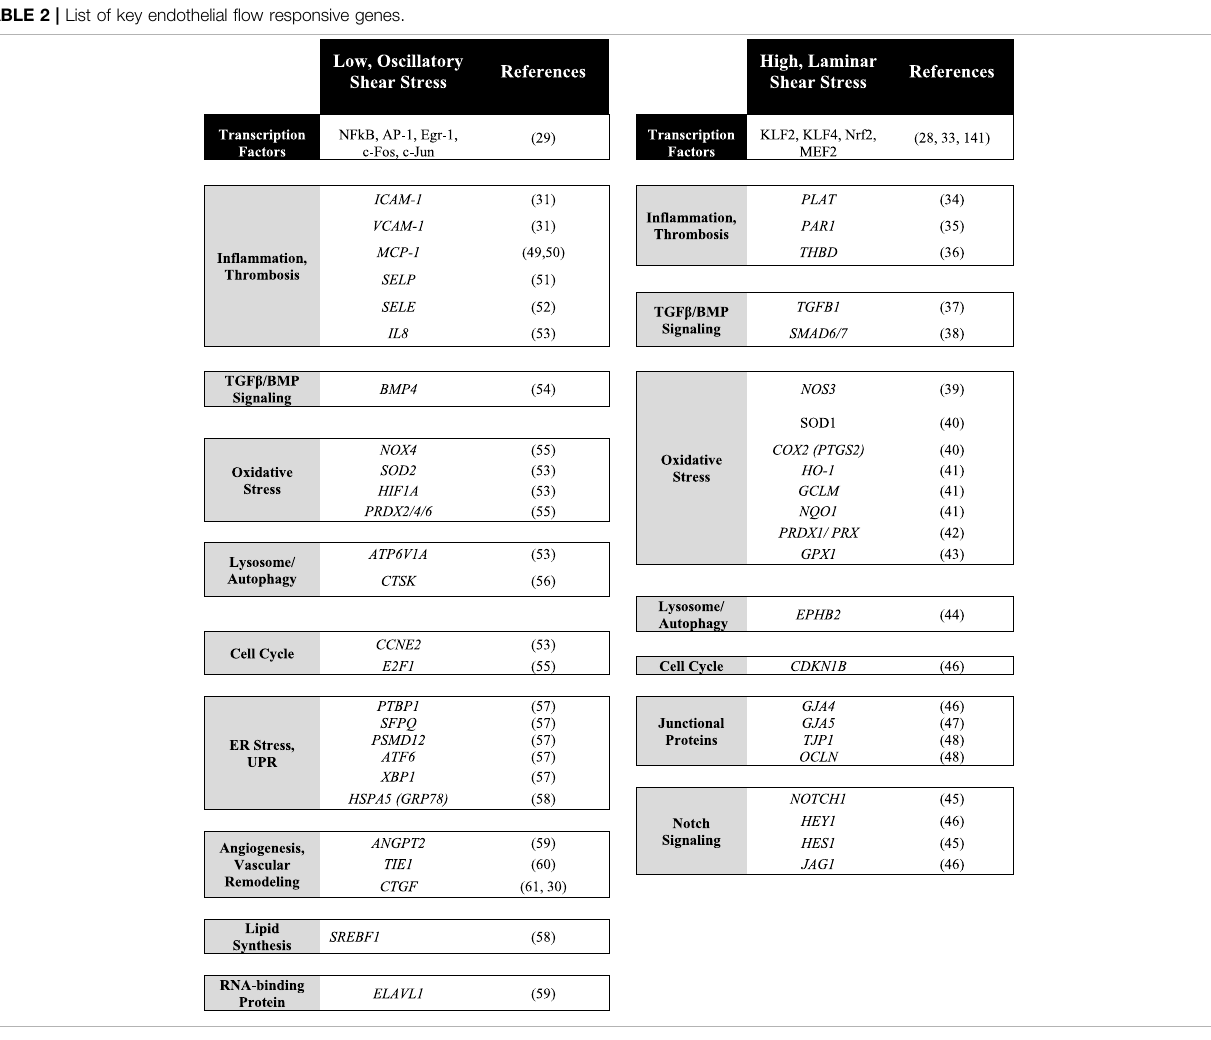
TABLE 2 | List of key endothelial fl ow responsive